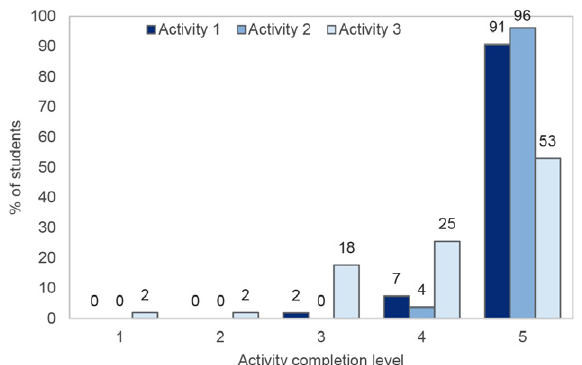
Figure 6: Distribution of perceived activity difficulty by activity (5 = difficult)